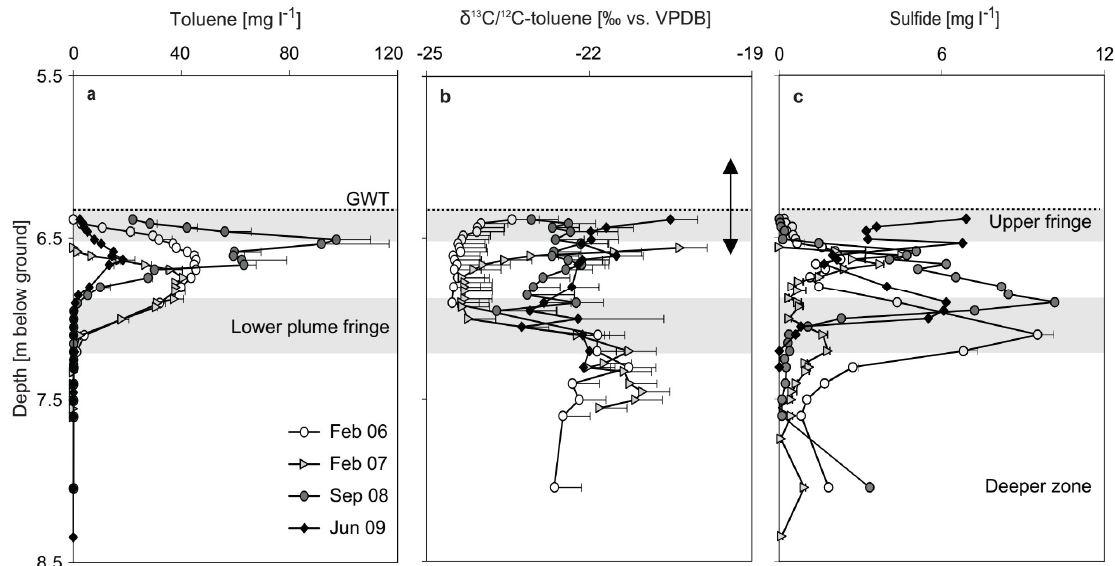
Figure 2. Depth profiles of toluene concentration, biodegradation, and sulfide in the Flingern aquifer over four successive sampling time points. ( a ) Toluene concentrations plus standard deviation (positive only); ( b ) toluene stable isotope ratios plus standard deviation (positive only); ( c ) sulfide concentrations plus standard deviation (positive only) from duplicate groundwater samples per time point and depth. The extent of groundwater table (GWT) fluctuations and shifts of the plume boundaries during the study period are indicated as a vertical arrow (at GWT). The localization of the upper and lower plume fringes is highlighted in grey, but averaged over the entire study period.